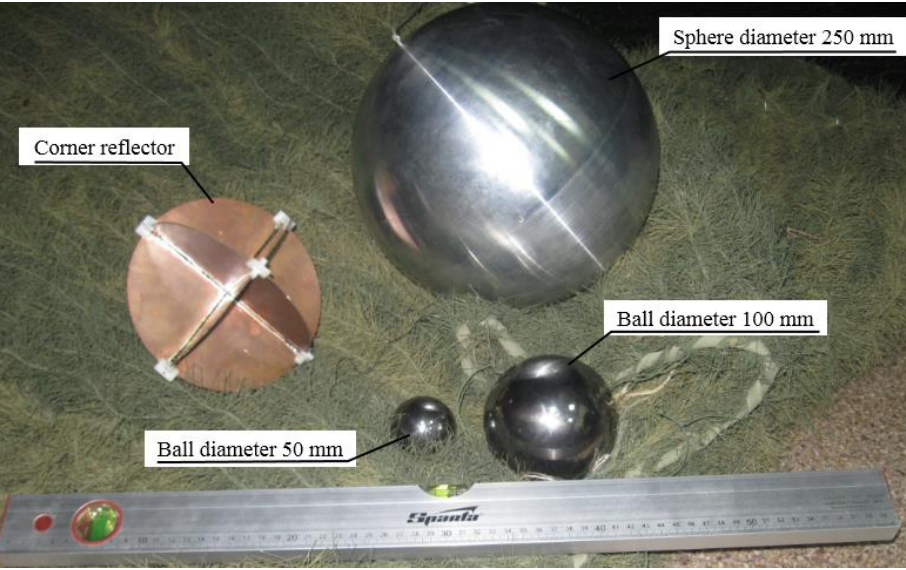
Fig. 5. Reference reflectors used for RCS